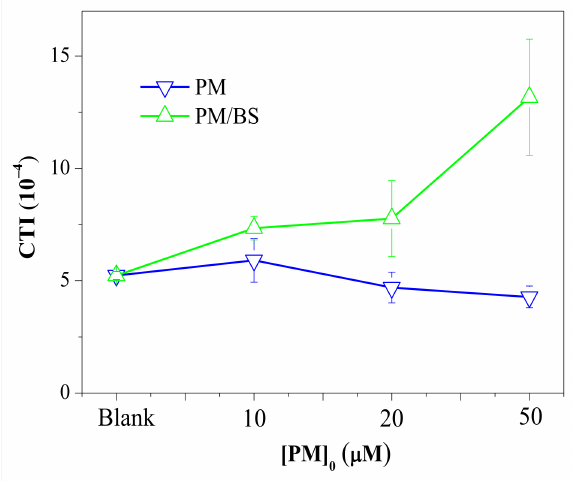
Figure 8. Changes of CTI in different doses of PM and BS. ((HA) o = 3 mg L − 1 , (PM) o = 0–50 µ M, (BS) o = 0–250 µ M and t = 30 min). Duplicated samples were analyzed.